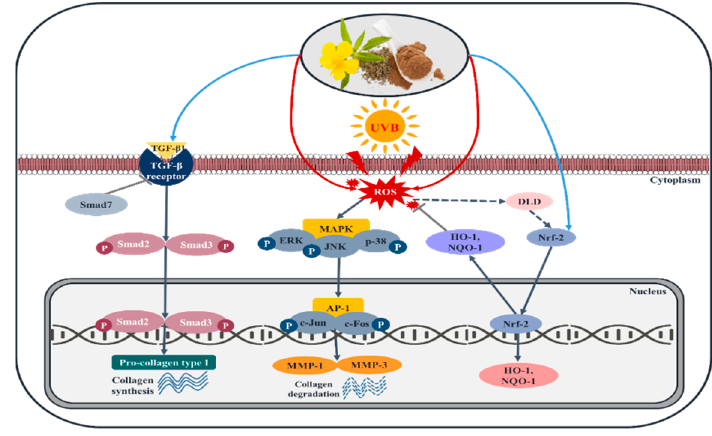
Figure 12. Damiana leaves on skin photoaging signaling.